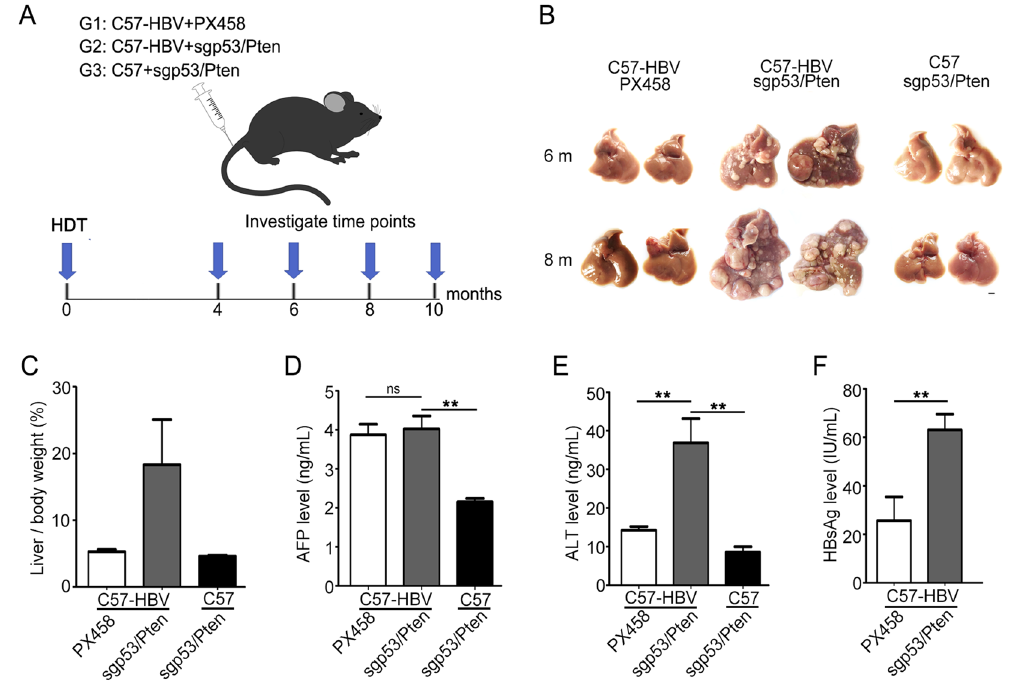
Figure 2. Hydrodynamic injection of dual sgRNA cassette accelerated tumor formation in HBV transgenic mice. ( A ) Cartoon showing hydrodynamic tail vein injection of dual sgRNA cassette to an adult mouse and the experimental design. HDT, Hydrodynamic tail vein injection. G1, group 1; G2, group 2; G3, group 3. ( B ) Liver tumors detected in the three groups of mice harvested 6 and 8 months’ post injection. Two representative photographs of mouse livers were showed in each group. At 6 months’ post injection, 3 mice in C57-HBV PX458 group, 3 mice in C57-HBV sgp53/Pten group, and 5 mice in C57 sgp53/Pten group were sacrificed. At 8 months’ post injection, the number of the sacrificed mice in the three groups were 3, 4 and 4 respectively. The scale bar is 5 mm. ( C ) Liver weight relative to the whole body weight of mice 8-month post injection. ( D & E ) Circulating AFP and ALT level in sera of the mice 8 months’ post injection with PX458 or dual sgRNA cassette. ( F ) HBsAg expression detection in sera of the C57-HBV mice 8-month post injection. Data represent means ± SEM (n ≥ 3). Statistical significance was determined with Student t two-tailed test. ** indicated P <